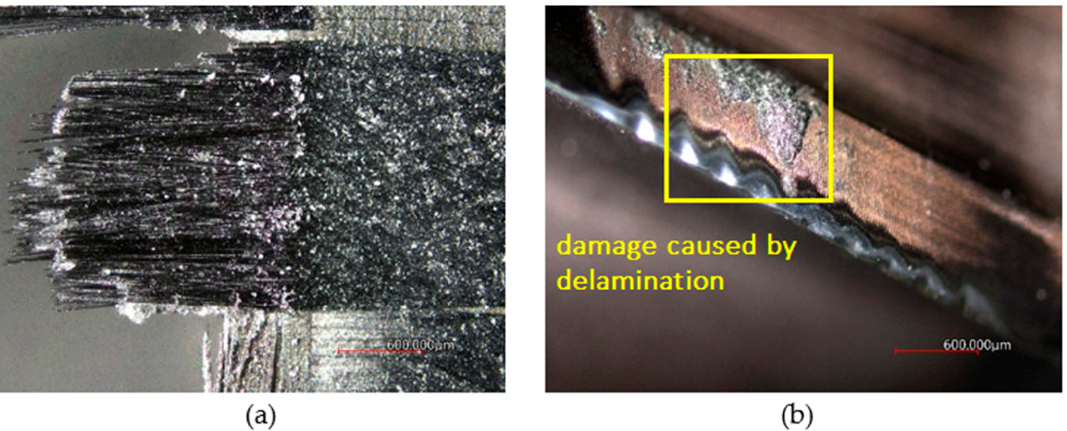
Figure 8. Capture after a tool tooth path of 15 × 165 m. ( a ) Laminate thickness 3 mm; ( b ) G550 milling tool.